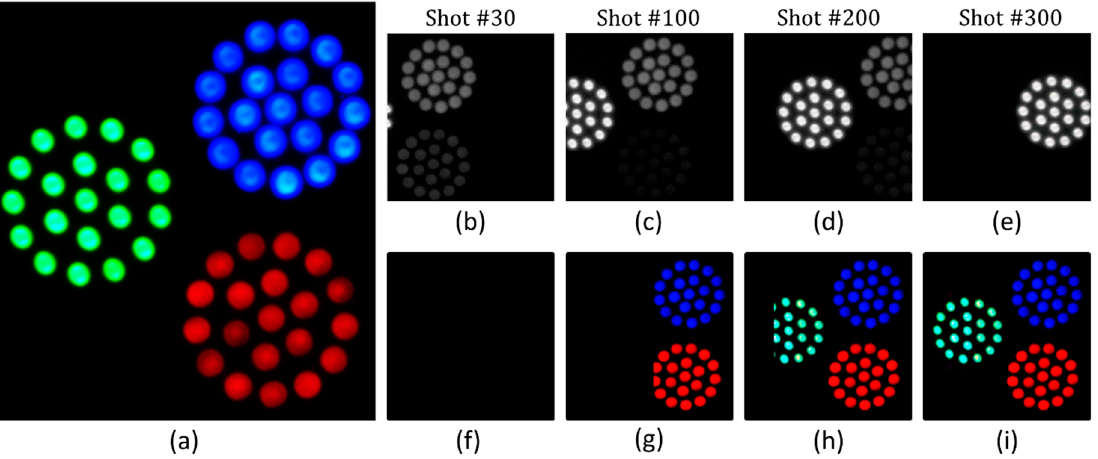
Figure 11. Scanning mode (Figure 10) reconstruction result. ( a ) RGB color image of three LED arrays. ( b – e ) representative single exposure images (frame #30, #90, #150 and #300, respectively) and ( f – i ) the RGB representation of the reconstructed HS image up to the appropriate column.